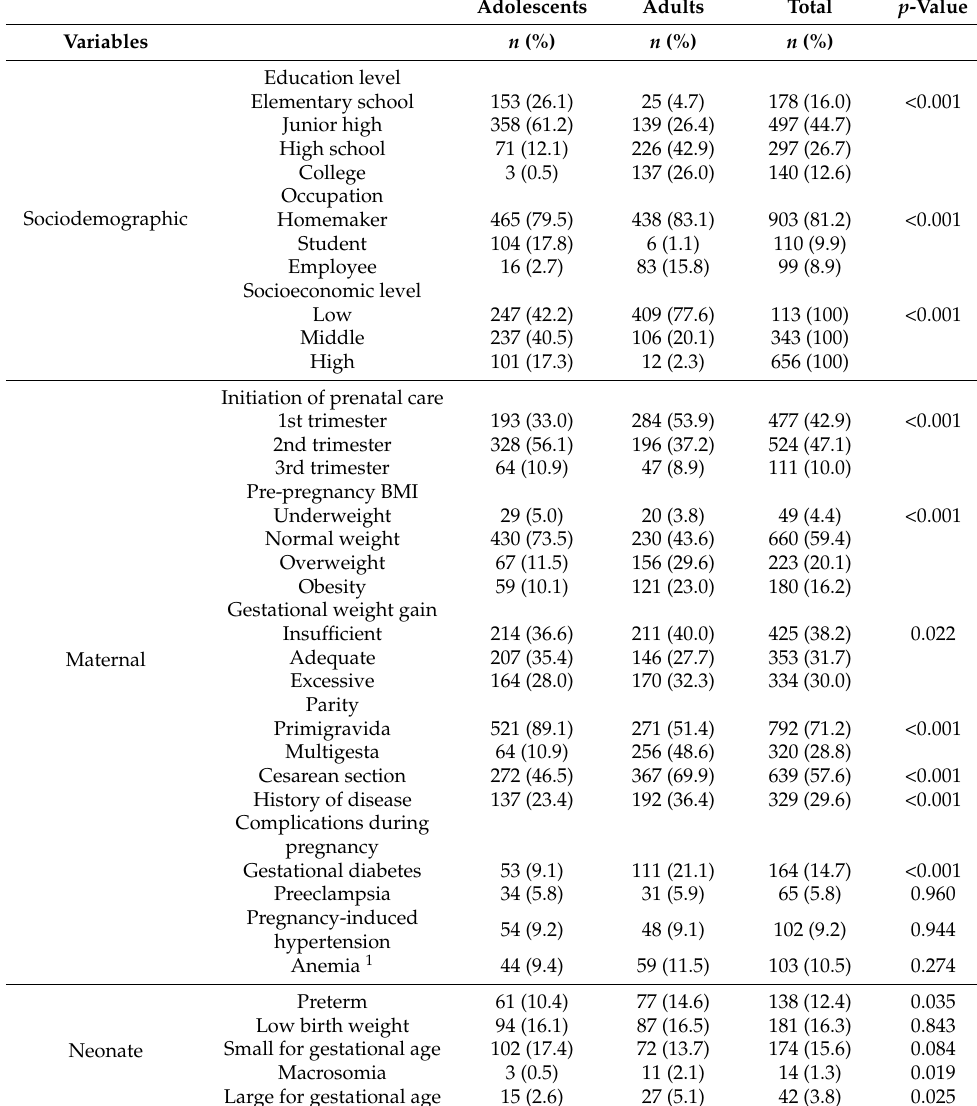
Table 1. Demographic and clinical characteristics of pregnant women and their